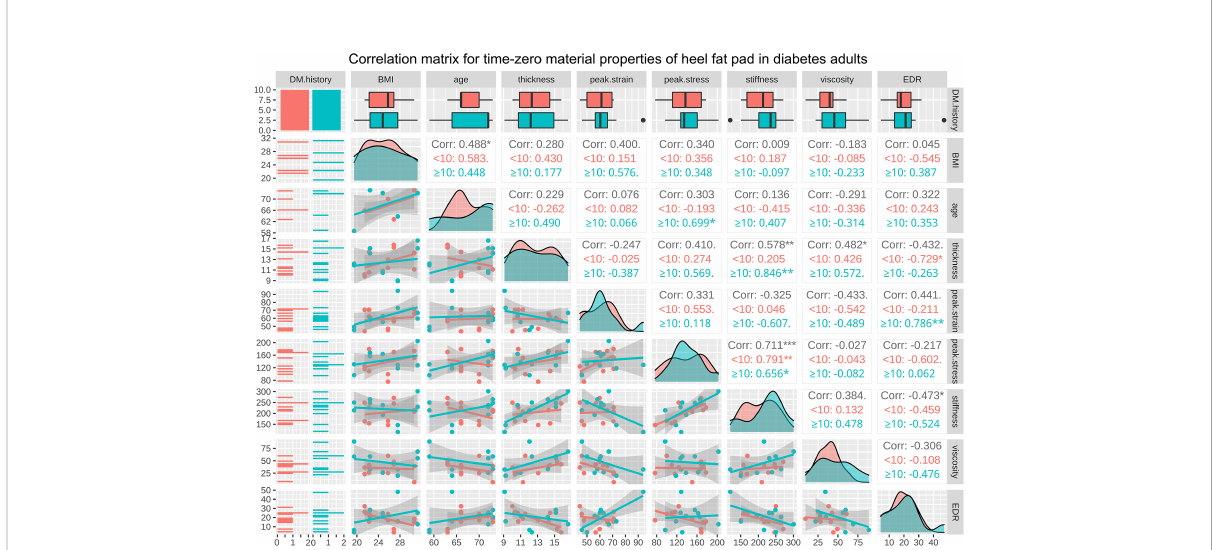
FIGURE 6 The correlation matrix for time-zero BMI, age, primary thickness, peak strain, peak stress, stiffness, viscous modulus, and EDR of heel in diabetes subjects. The values displayed in the right-upper triangle represent the Pearson ’ s correlation coef fi cients (R values). The lower-left triangle displays the scatter plots and regression lines. The plots on the diagonal line present the distribution density of the variables in the matrix. Subgroup analysis was conducted basing on the diabetes course (<10 years and ≥ 10 years), and red colour represents subgroup of <10 years while cyan colour represents subgroup of ≥ 10 years. BMI: body mass index; EDR= energy dissipation rate. P values:.p<0.100, *p<0.050, **p<0.010,